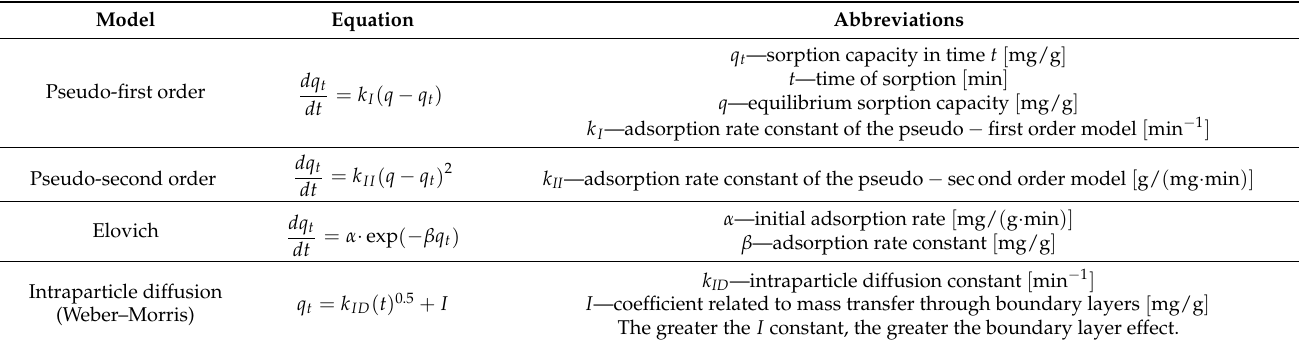
Table 2. Equations and parameters of kinetic